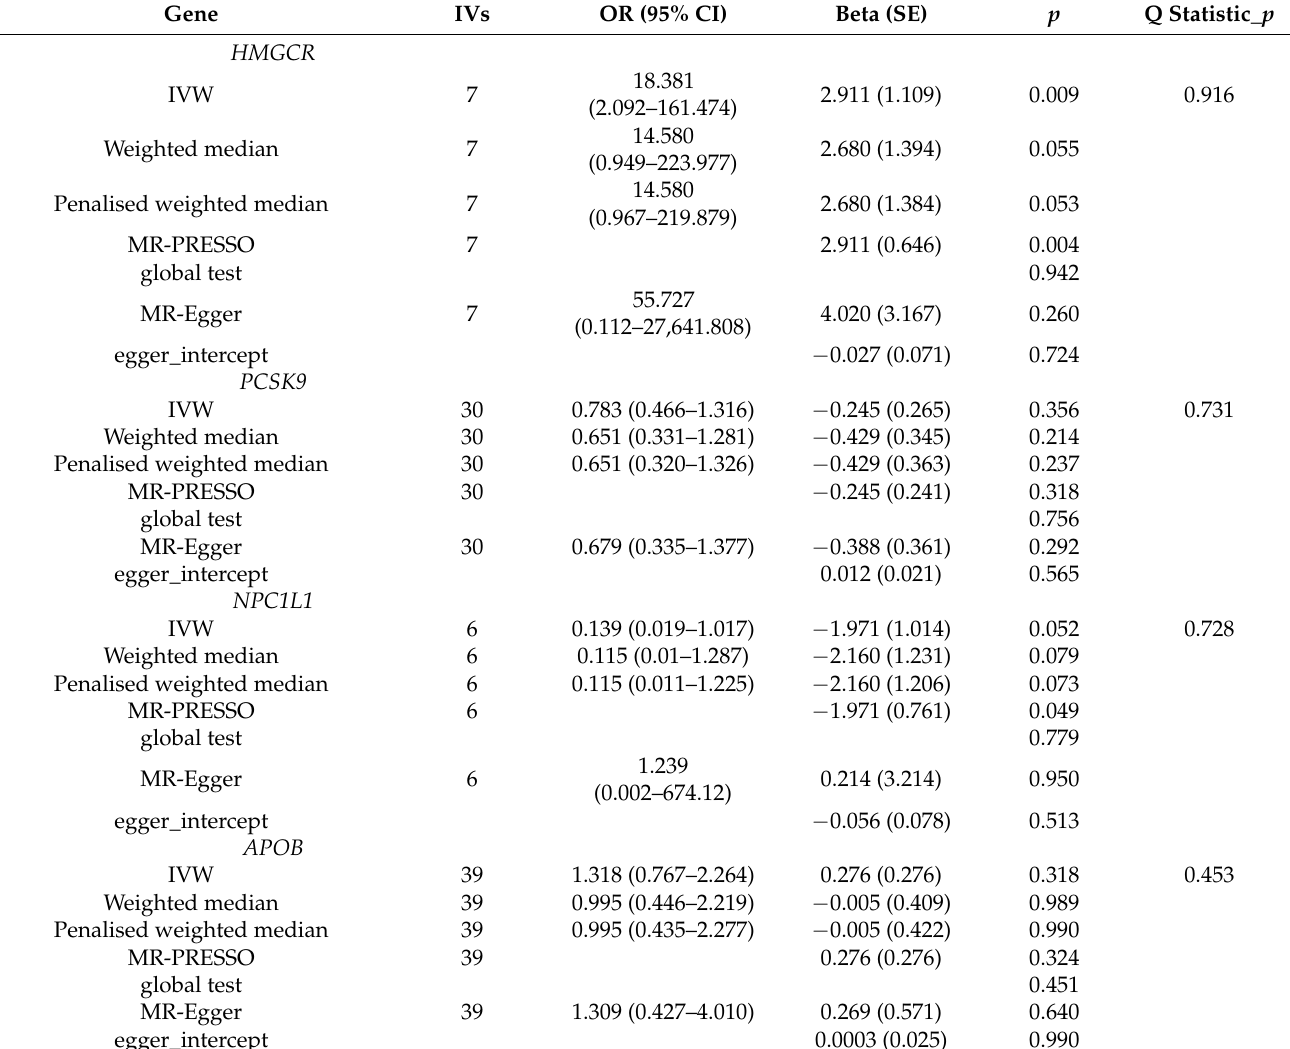
Table 2. Causal effects of LDL-C mediated by target genes on vascular dementia via MR